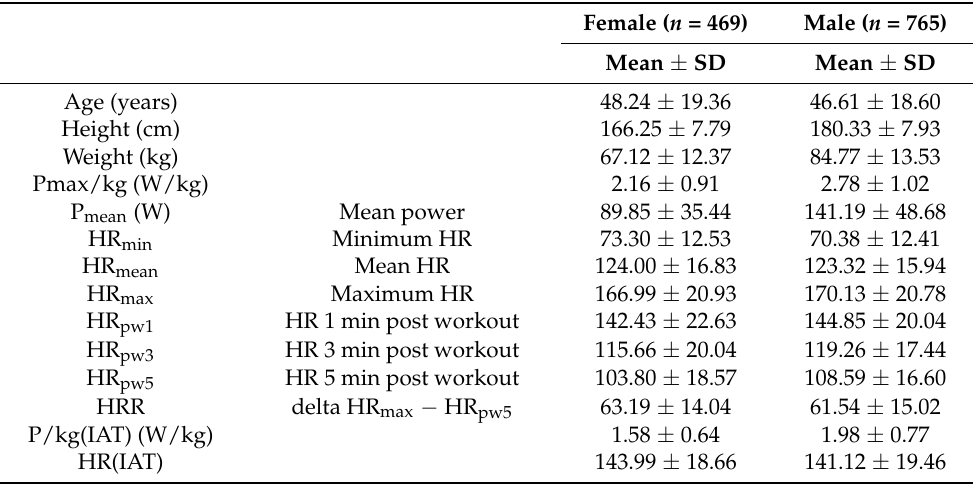
Table 1. Descriptive characteristics of female and male